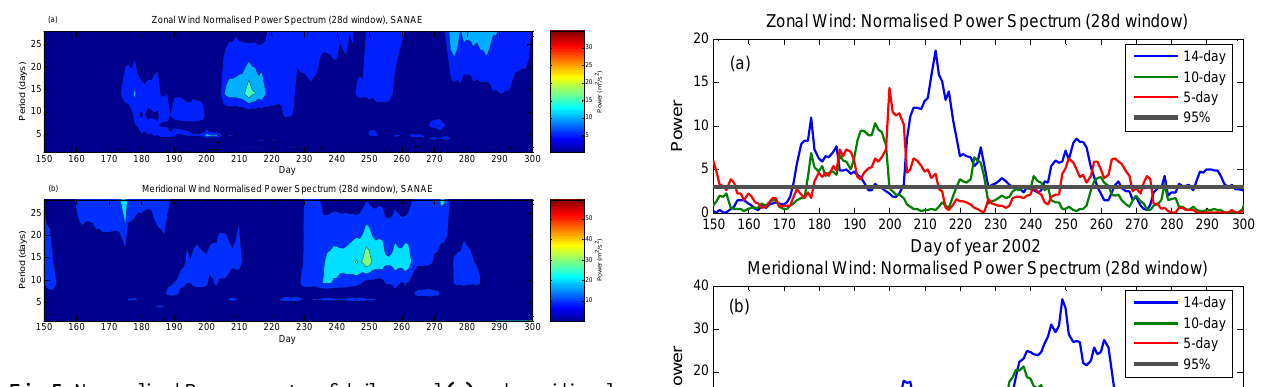
Fig. 5. Normalised Power spectra of daily zonal (a) and meridional wind (b) derived for the MLT region (~94km) from SANAE HF radar for the period from 30 May to 27 October 2002 (150-300 Julian days).